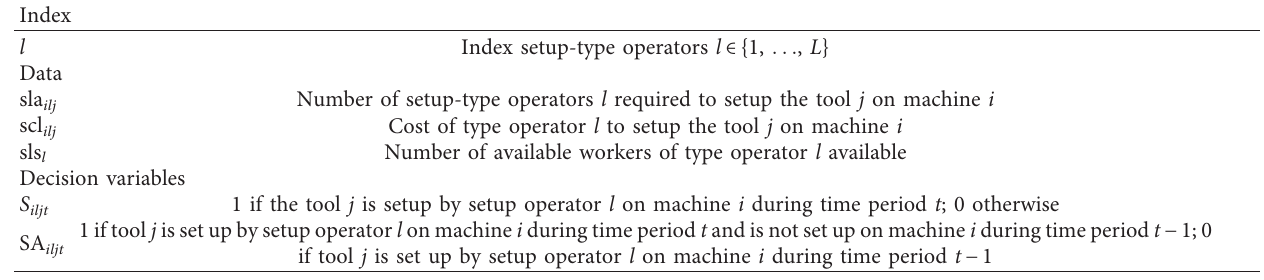
Table 3: Nomenclature for the